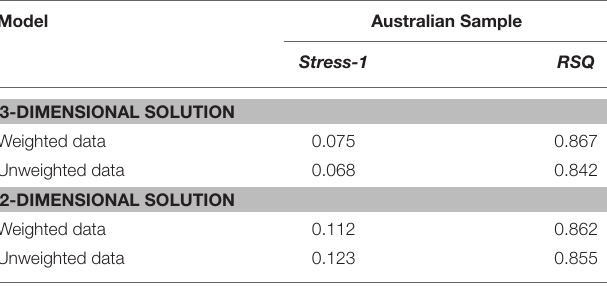
TABLE 2 | Model Fit Results for Study 1 with the Australian sample using Classical MDS with and without weighted data derived from cultural consensus analysis (see text for